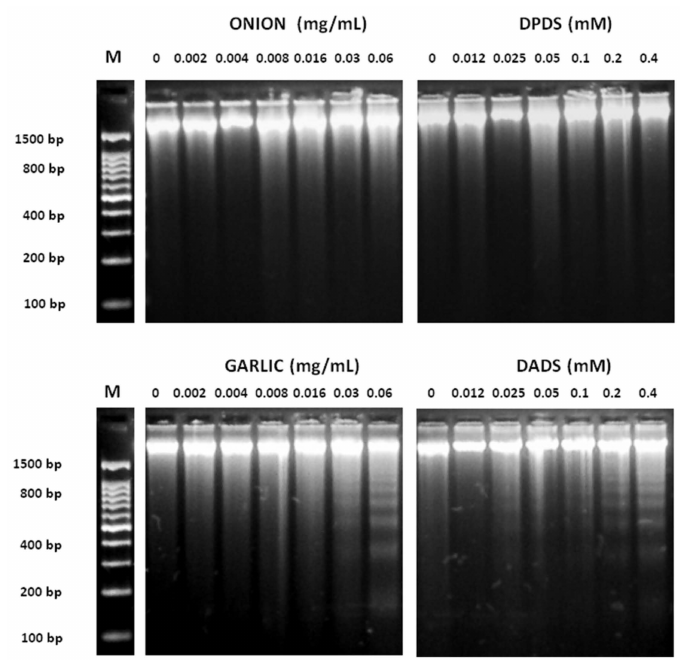
Figure 4. Inter-nucleosomal DNA fragmentation. HL-60 cells were exposed to various concentrations of onion, garlic, and their distinctive organo-sulfurs for 5 h. DNA was extracted from cells and was subject to 2% agarose gel electrophoresis at 50 V for 90 min. M: DNA size